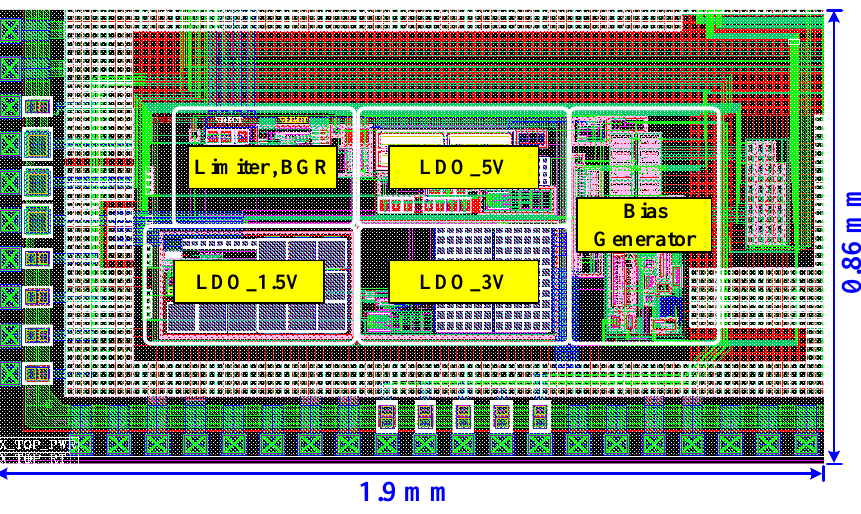
Figure 5. Top layout pattern of the proposed power regulated circuit